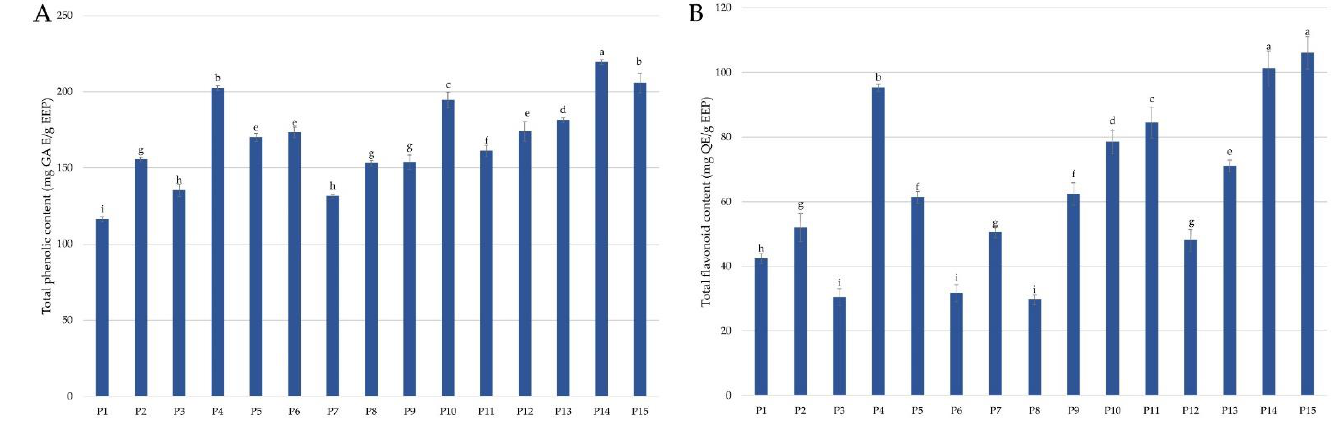
Figure 1. Total phenolic content ( A ) and total flavonoid content ( B ) in propolis extracts. (Values denoted with identical letters do not differ significantly).